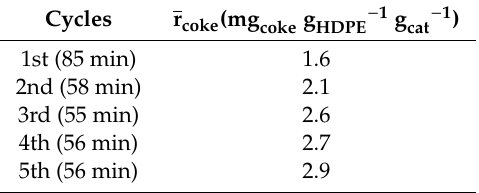
Table 1. Average coke deposition for five consecutive reaction-regeneration cycles.